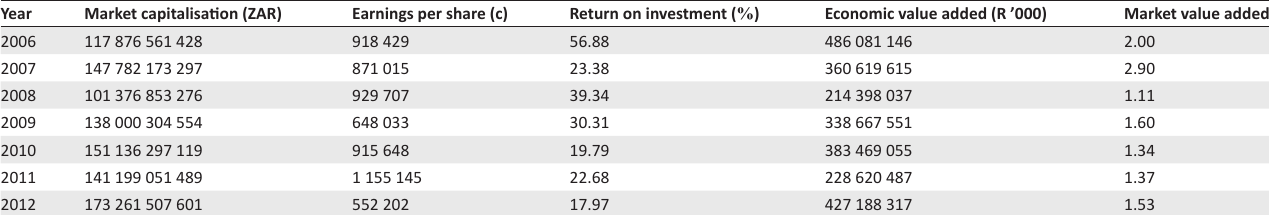
TABLE 5: Organisational performance measures standard